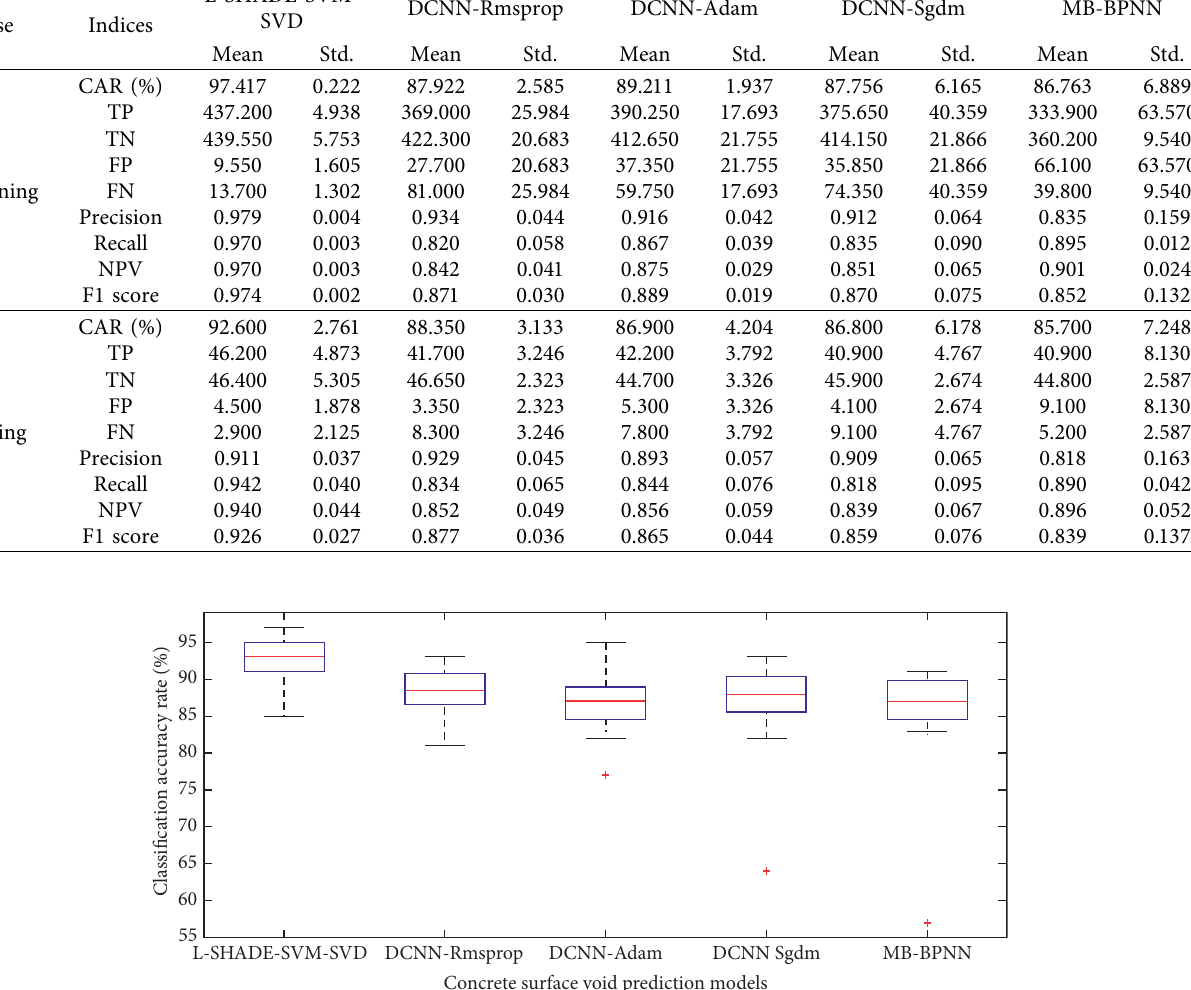
Figure 7: Box plots of model performances. Table 5: The t -test outcomes of pairwise model comparisons. Model